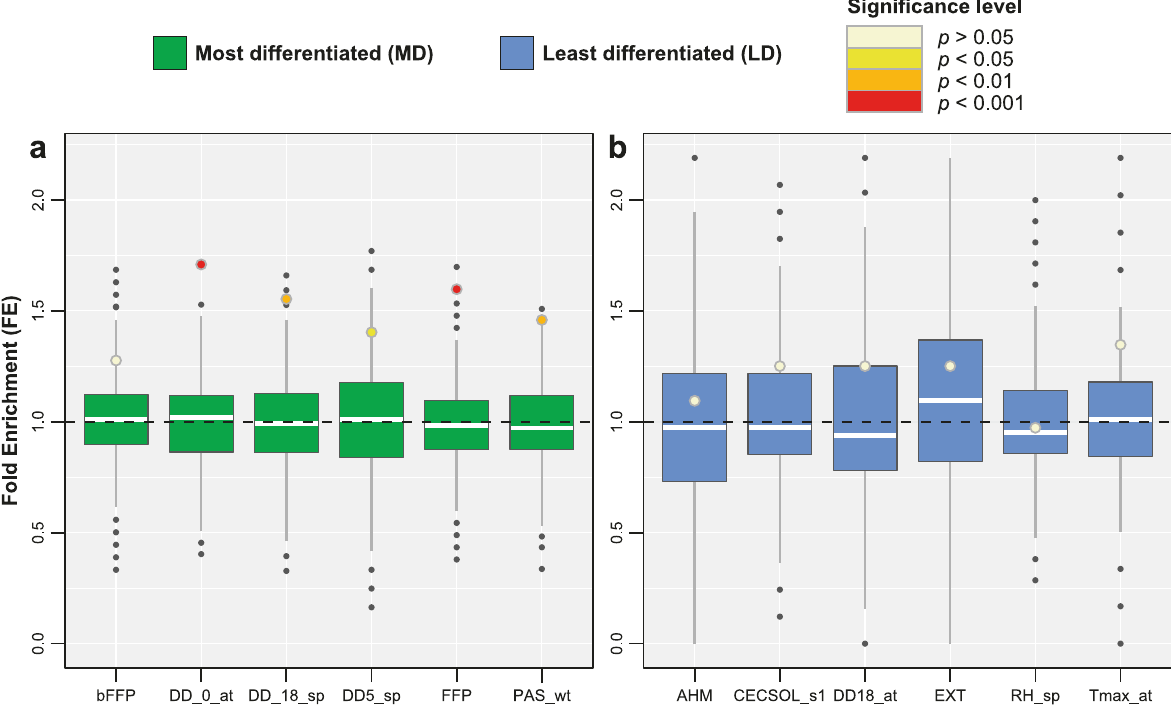
Fig. 4 Fold enrichment (FE) of P. fl exilis ancestry along most differentiated and least differentiated environmental gradients. Boxplots represent the distribution of 10,000 permuted FE values and the fi lled in circles indicate the FE for outlier sets of SNPs associated with environmental gradients that were a strongly divergent between the two species and b least divergent between the two species. For each boxplot the whiskers represent 1.5 times the Inter- quantile